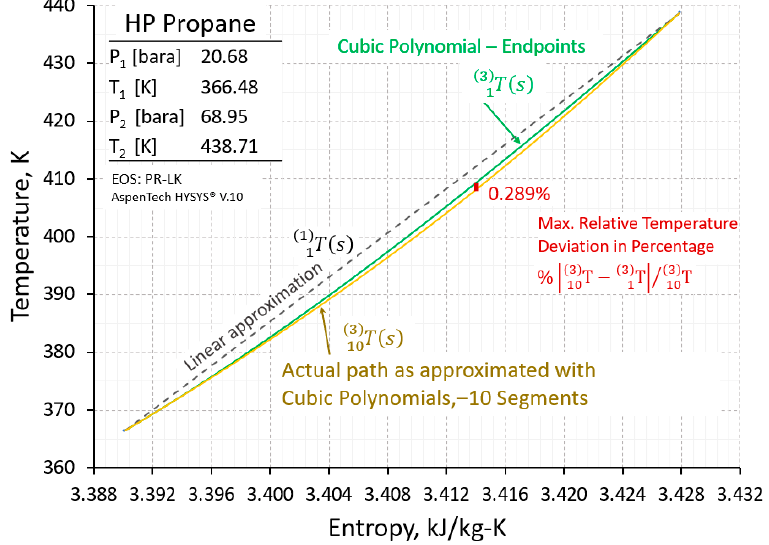
Figure 4. Temperature deviation of the cubic polynomial endpoint method from the actual polytropic path as approximated with 10-segment piecewise cubic polynomial approximants is shown. The highest temperature deviation is 1.185 K (0.289% relative deviation), at s = 3.414 kJ/kg-K. The